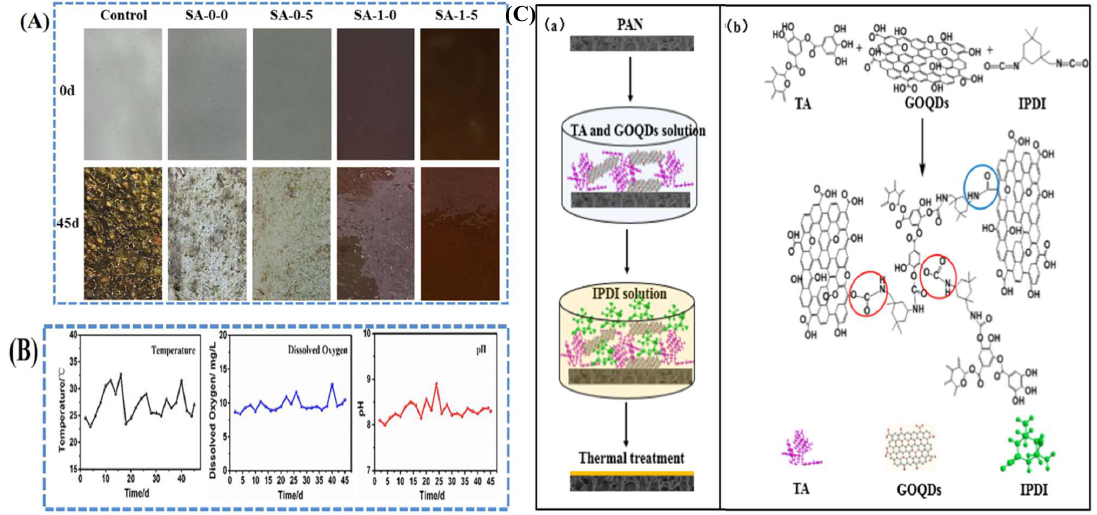
Figure 11. ( A ) Picture of samples submerged in seawater till 45 days; ( B ) temperature, oxygen, and pH level of seawater (reproduced with permission from [113] copyright 2021, Elsevier); ( C ) preparation and mechanism of graphene oxide nanocomposite membrane (reproduced with permission from [118] copyright 2021, ACS).